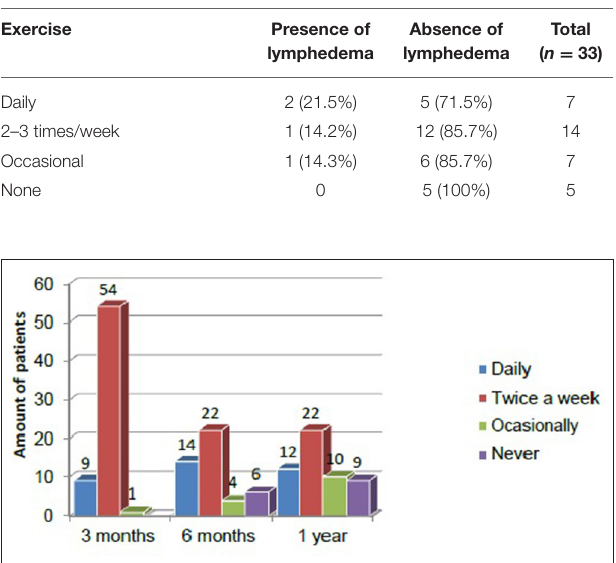
TABLE 5 | Lymphedema incidence at 2 years according to the frequency of exercises in the experimental group.